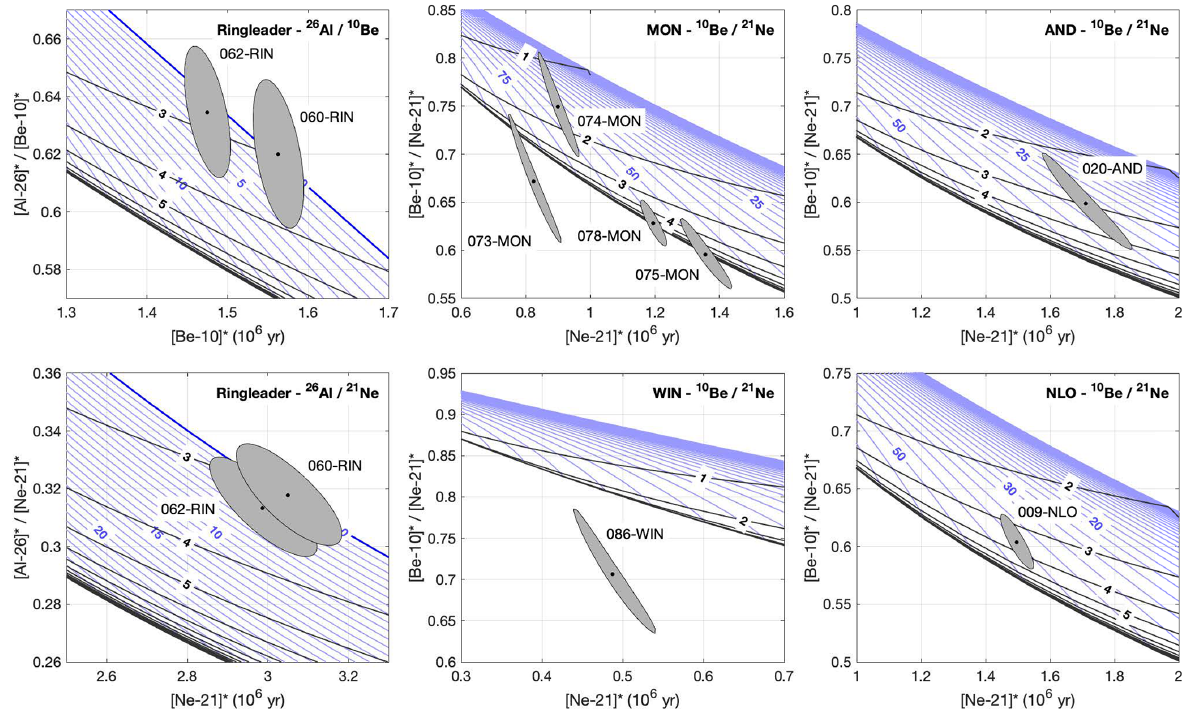
Figure 11. Two-nuclide diagrams for all sandstone erratics collected from Lower Roberts Massif moraines. The construction of the diagrams is the same as in Fig. 10. Two-nuclide data for sandstones on the Ringleader moraine lie on the simple exposure line and are in agreement with 3 He ages, suggesting that these samples experienced a single period of exposure at negligible erosion, and their apparent ages are a good estimate of the true age of the moraine. On the other hand, paired-nuclide data from sandstones on the MON, WIN, AND, and NLO moraines require either significant erosion or a multistage exposure history. An erosion explanation would predict that their apparent ages should be younger than 3 He ages on the same moraines; as this is not the case, these samples most likely experienced a multistage exposure history and therefore were emplaced with significant nuclide